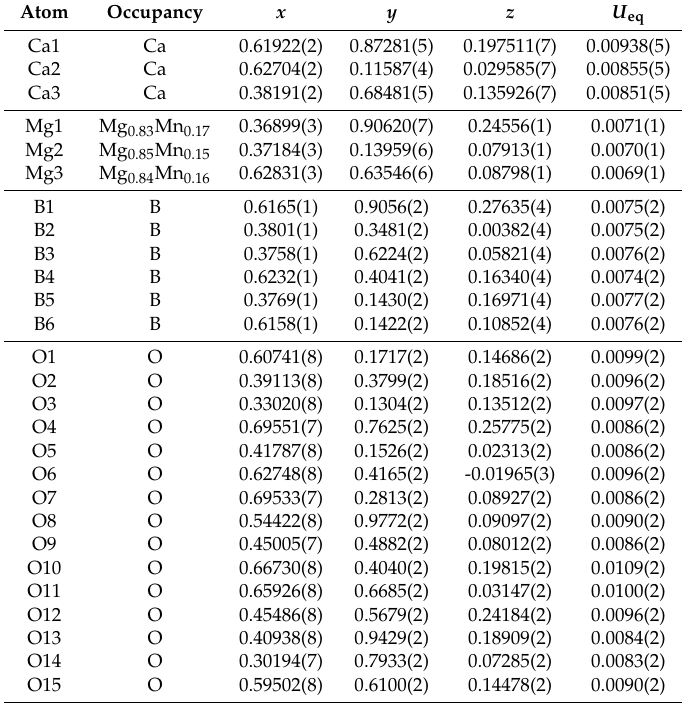
Table 3. Atomic coordinates, site occupancies and isotropic displacement parameters (Å 2 ) for